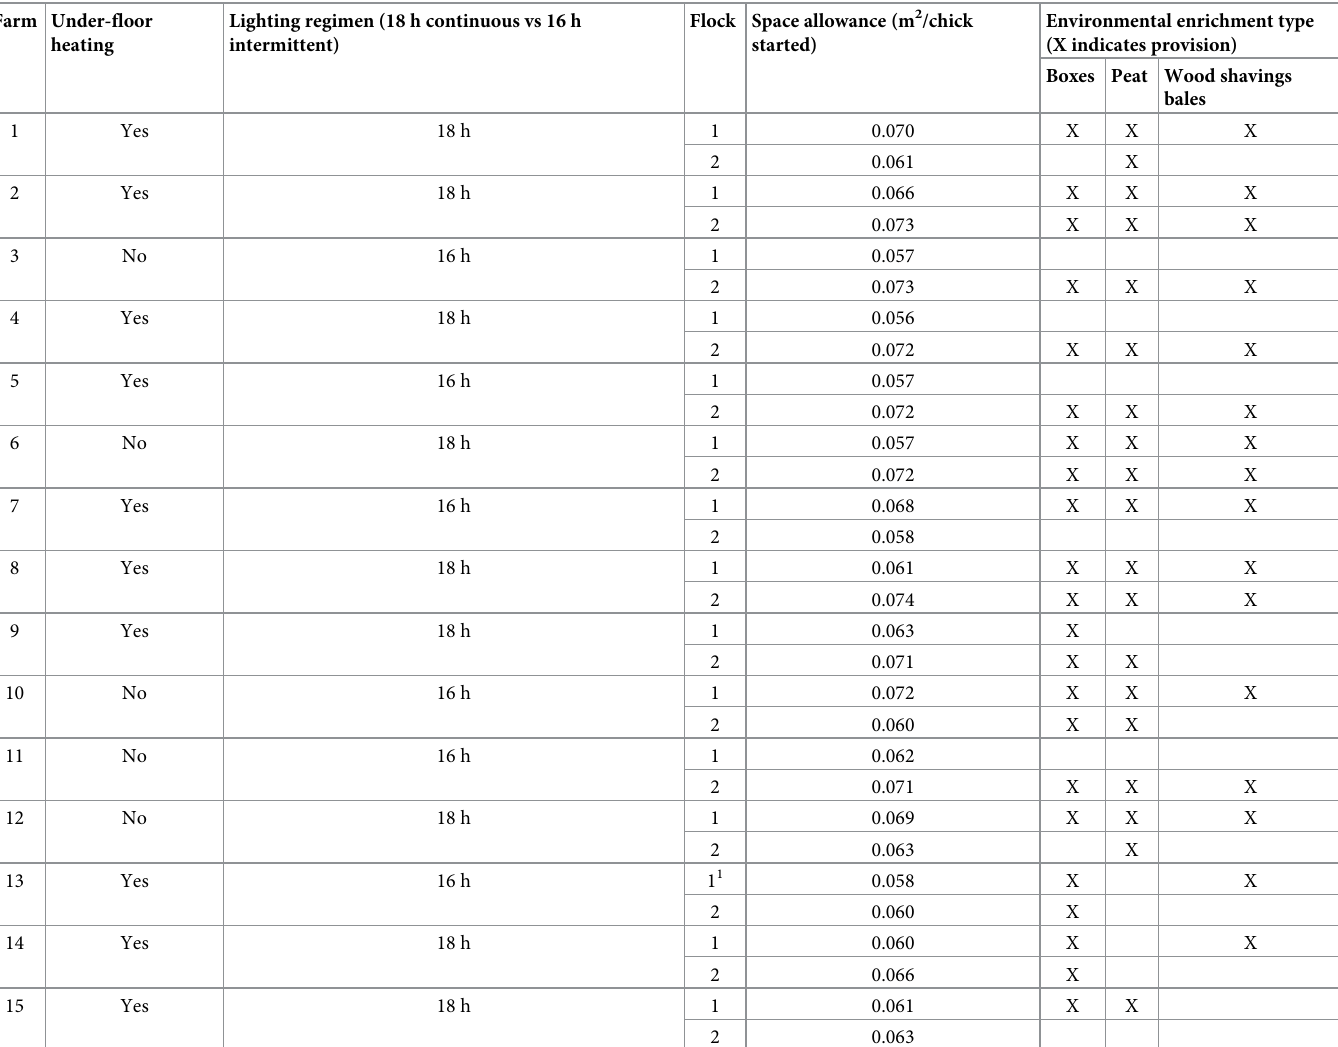
Table 1. Environmental provisions to each